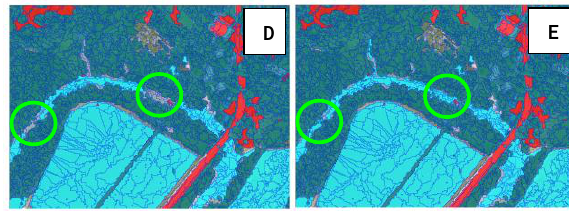
Figure 9. Water classification using assign class algorithm with mean CHM maximum threshold value of 0.2.